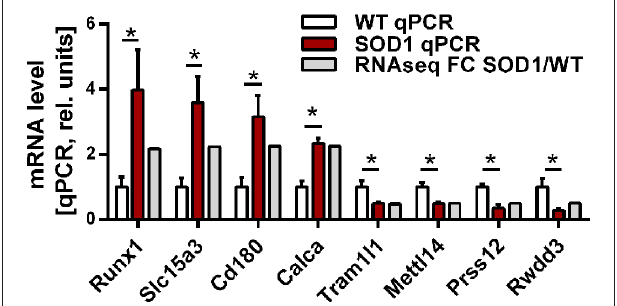
FIGURE 1 | Expression level of selected genes as determined by RNA-sequencing and qPCR. Validation of differential gene expression by qPCR and compared to the fold change determined by RNA sequencing. qPCR values were normalized to the mean of the respective WT group. qPCR data is presented as mean ± standard variation of the mean. FC, fold change; * p < 0.05.